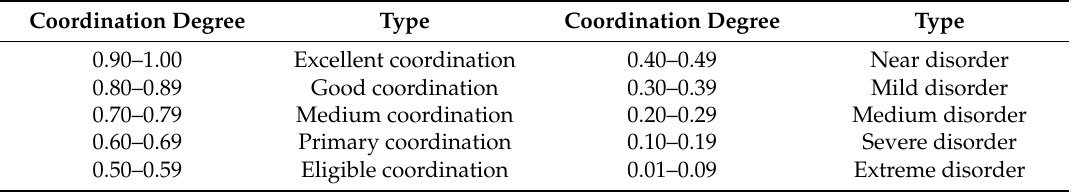
Table 2. Coordination type between the WRES and the HQEDS.